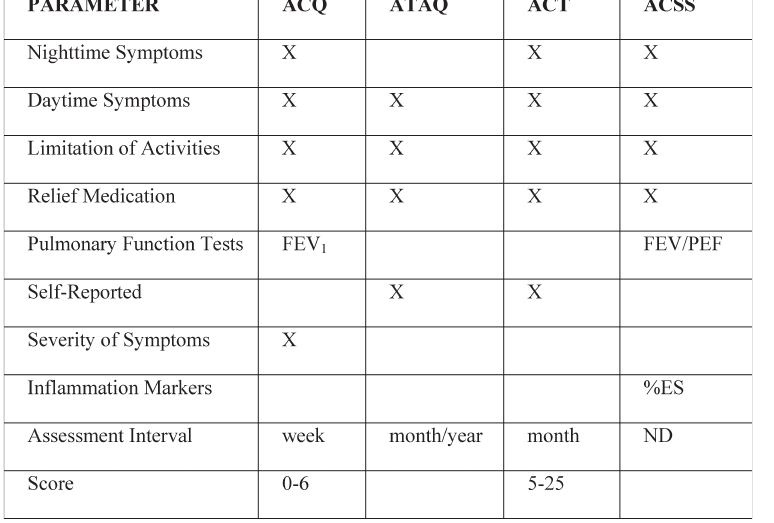
Figure 6 - Questionnaires to measure asthma control. ACT: asthma control test; ACQ: asthma control questionnaire; ATAQ: asthma therapy assessment questionnaire; ACSS: asthma control scoring system; FEV 1 : forced expiratory volume in one second; PEF: peak expiratory flow; and %ES: percentage of eosinophils in sputum; ND: not